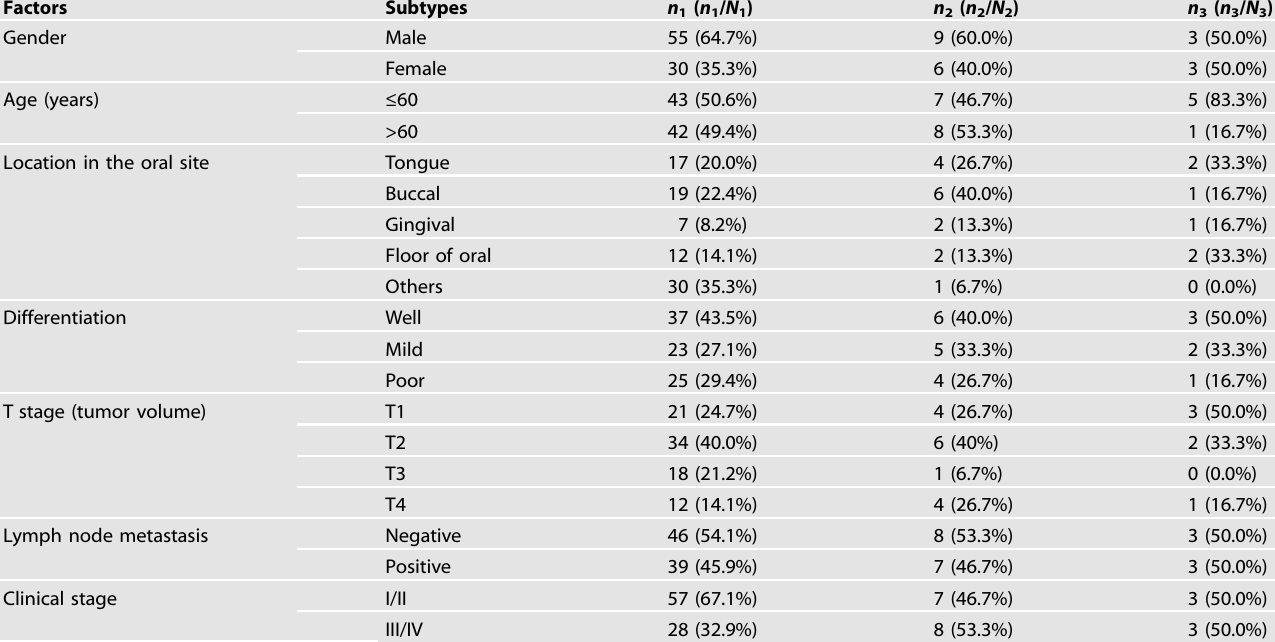
Table 1. Clinical histopathological features of OSCC samples used for IHC staining, CAFs ’ isolation, culture and